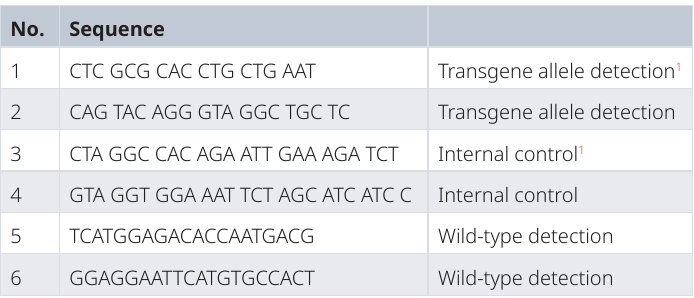
Table 1. Genotyping primer